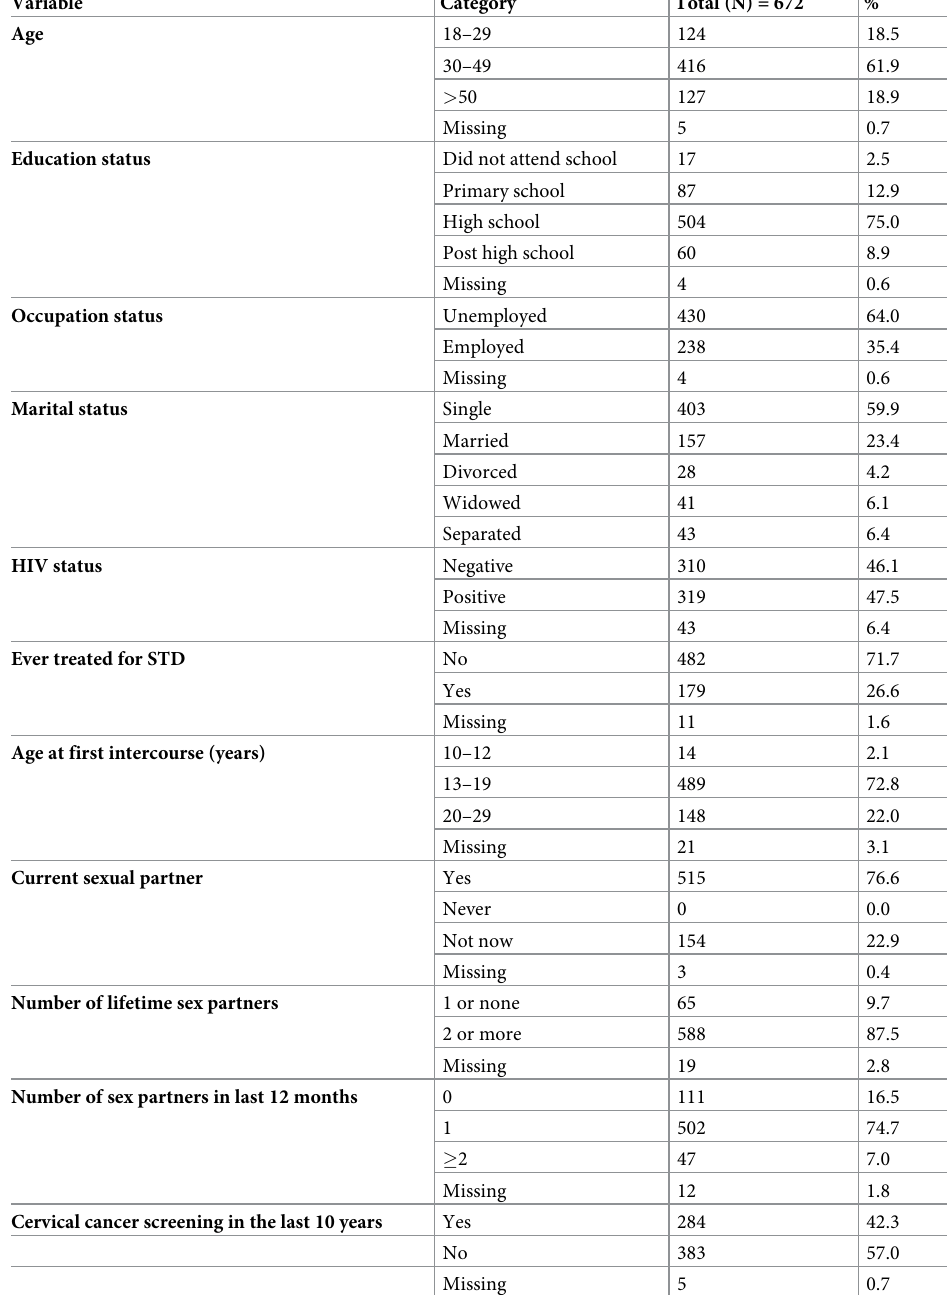
Table 1. Socio-demographic characteristics of black women attending Pap smears in primary hea1lth care clinics in Gauteng Province, South Africa (N = 672).